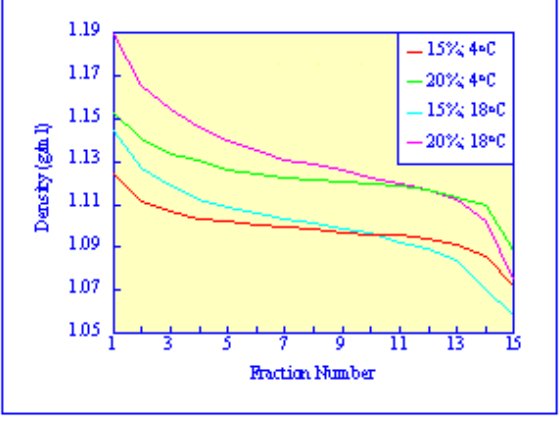
FIGURE 2 . Density profiles: 350,000 g for 1 h in